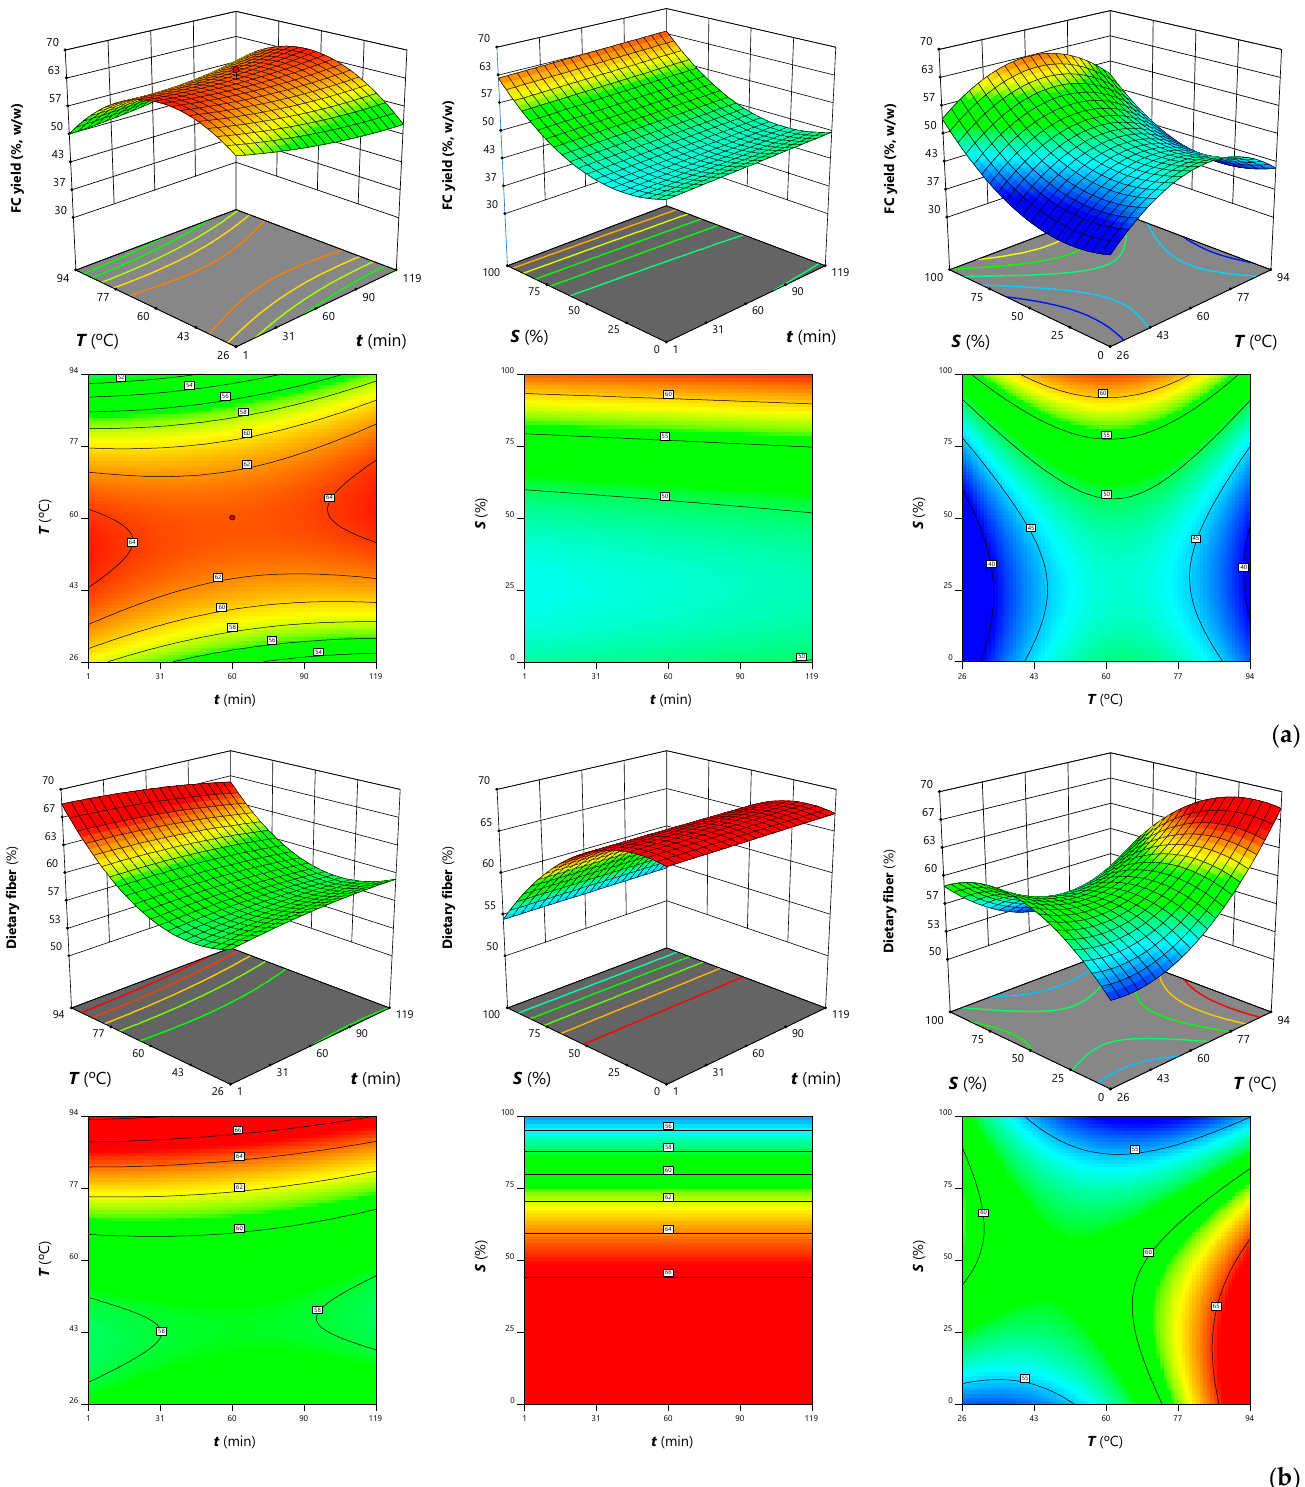
Figure 5. Response plots illustrating the effects of the independent variables on FC yield ( a ) and dietary fiber content ( b ) obtained from quince peel. In each plot, the unplotted independent variables was kept constant at its optimum, shown in Table S5.